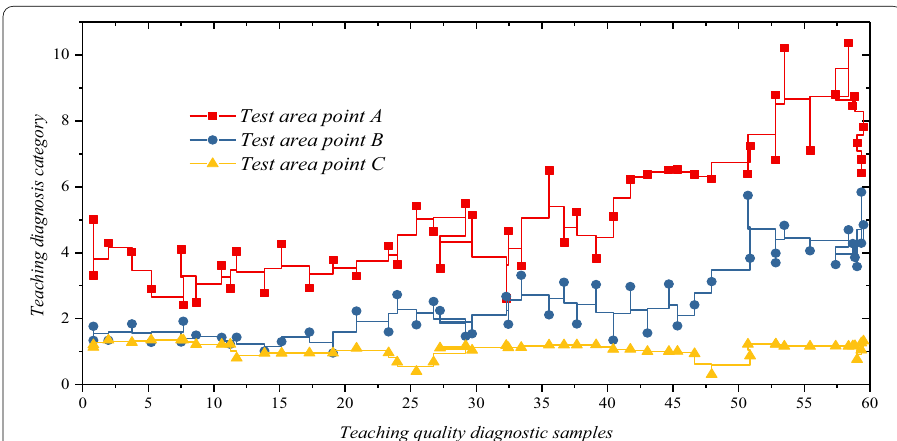
Fig. 4 Comparison of wireless sensor network throughput performance under TCP/ TFRC